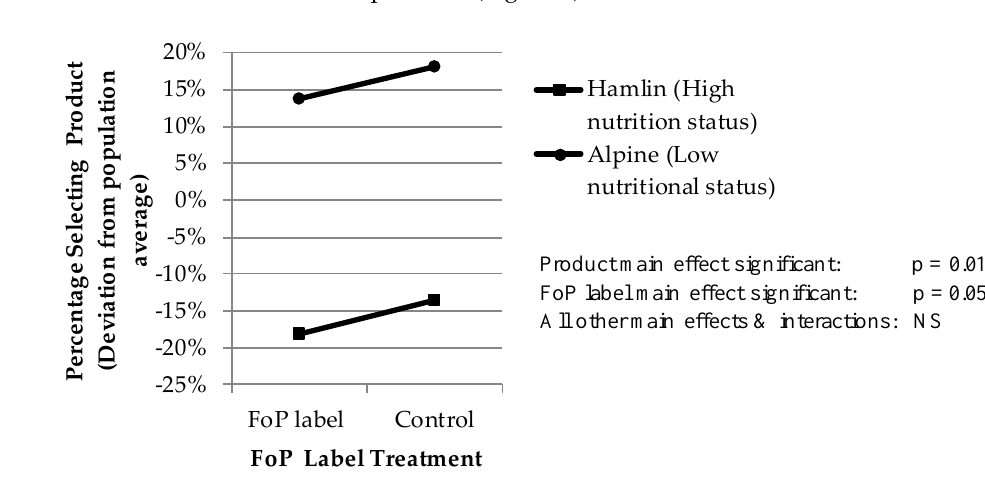
Figure 3. Result of the 2014 trial (Hamlin & McNeill, 2016 [41]).